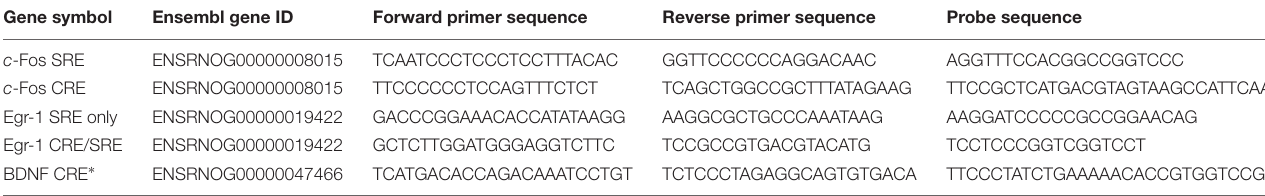
TABLE 2 | Primers and probe sequences used in ChIP analysis, including gene symbol and Ensembl gene ID for the target